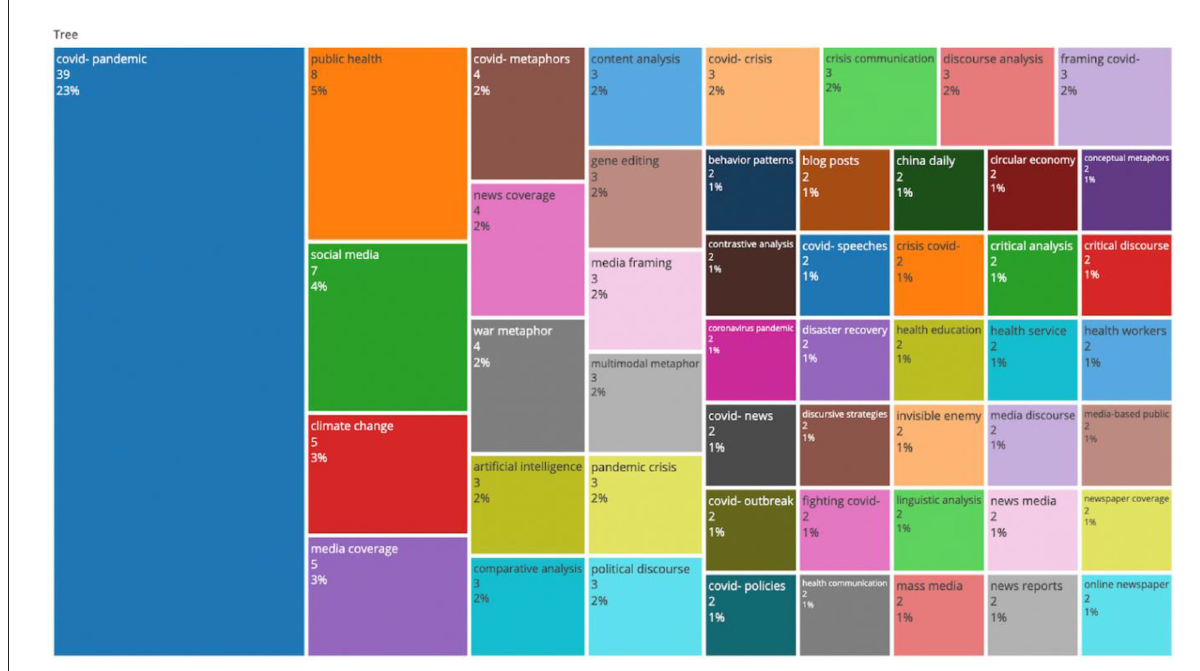
FIGURE8 A tree map of the 50 most frequently used bigrams of research titles.